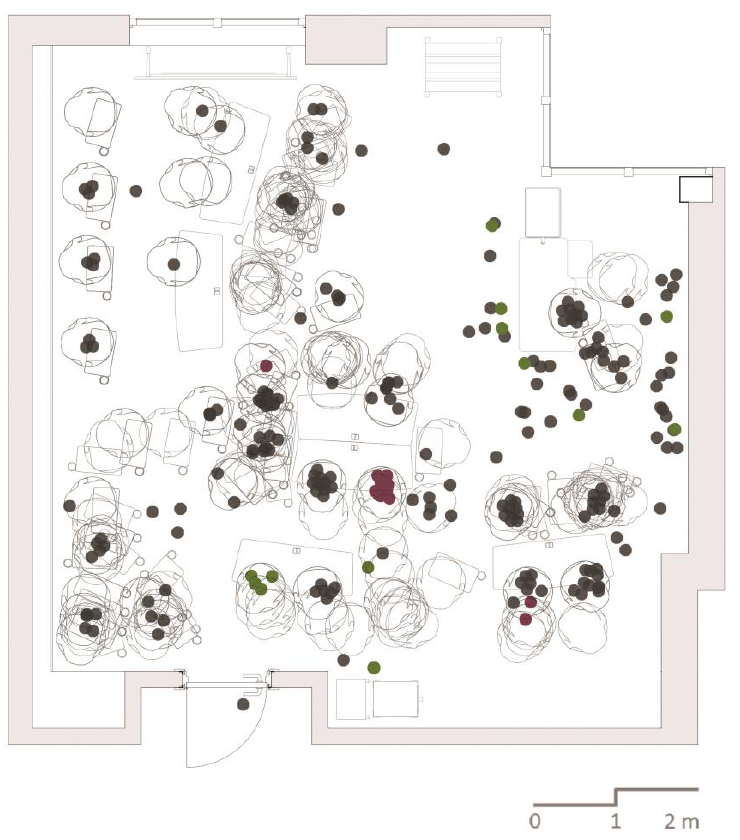
Figure 5. Overall behavior map of the observed workshop indicating observations of selected participants for simulations.